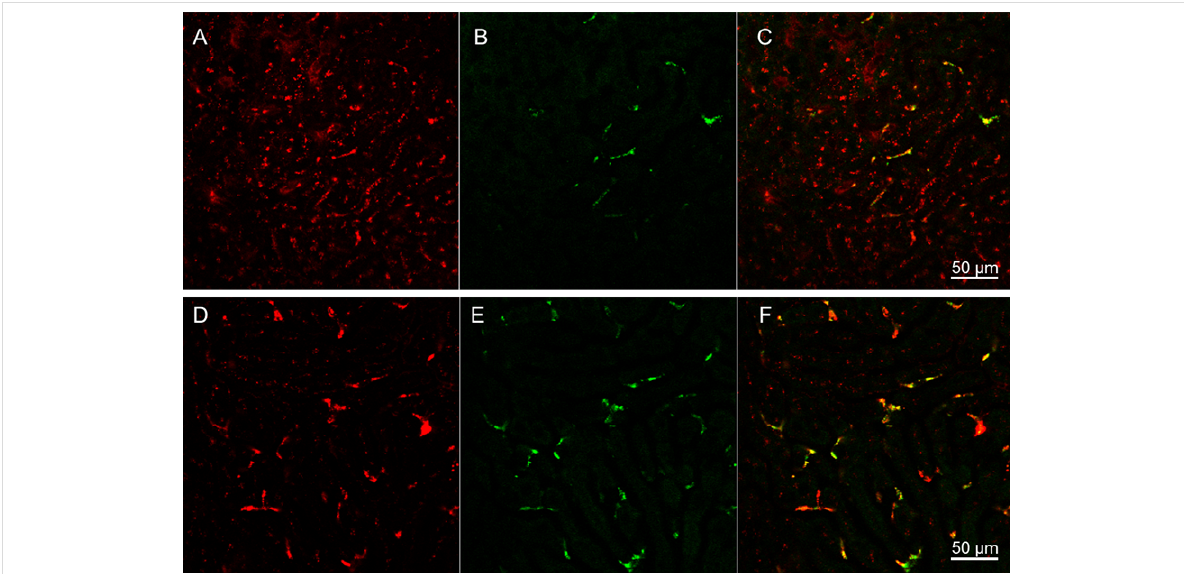
Figure 4: LDL receptor dependent uptake of QDs-micelles and LDL. Native LDL (red) and QDs-micelles (green) were injected into wild type C57BL/6 mice (upper panel) or into LDL receptor deficient mice (lower panel). 30 min after injection, the livers were excised and directly placed on the micro- scope for confocal imaging. In the wild type situation, LDL particles were predominantly internalized by hepatocytes (A) whereas.